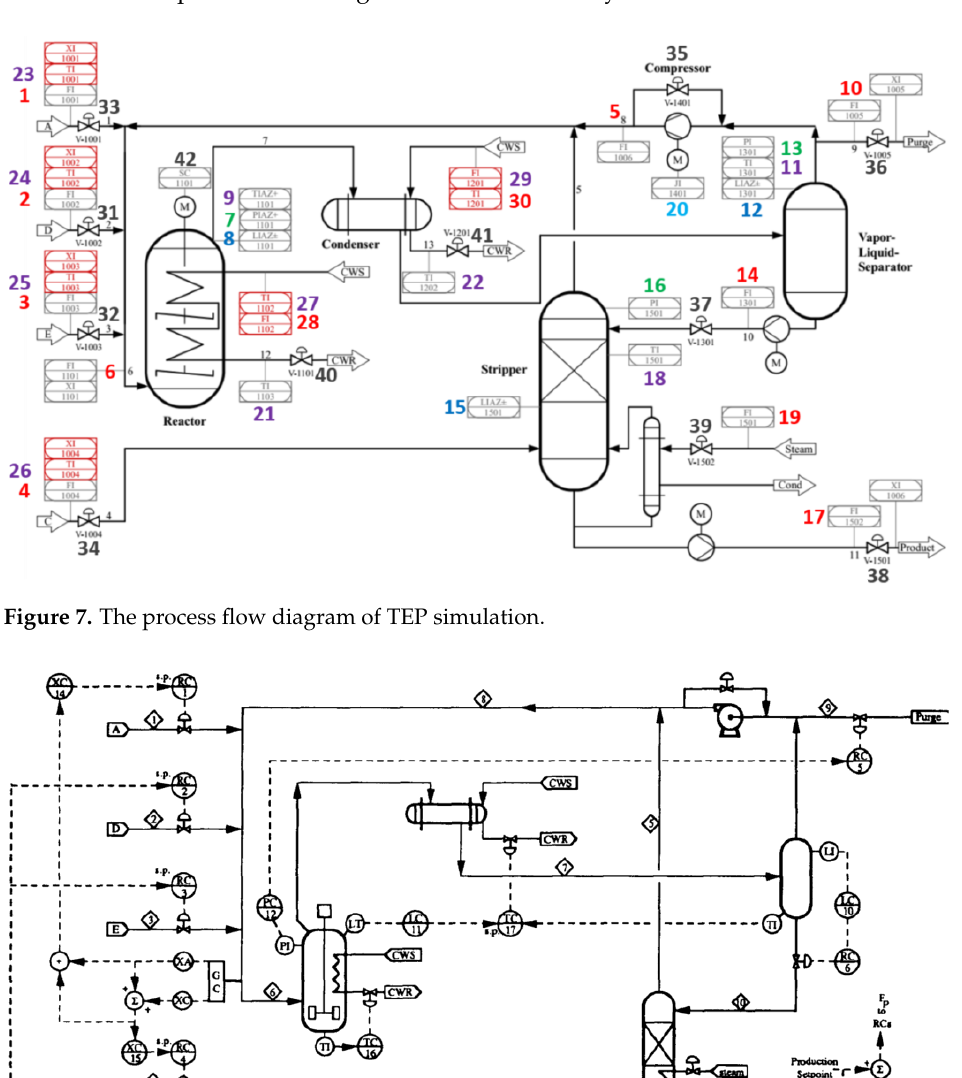
Table 3. The structure of the DLAN model for TEP.